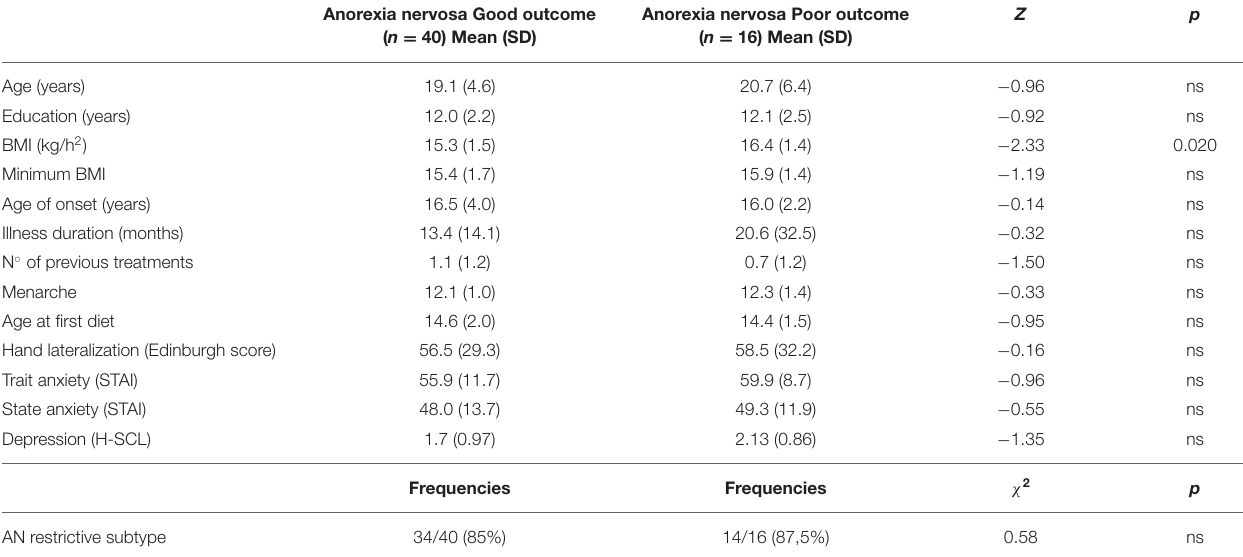
TABLE 3 | Clinical and general characteristics of patients with good and poor outcome at admission.